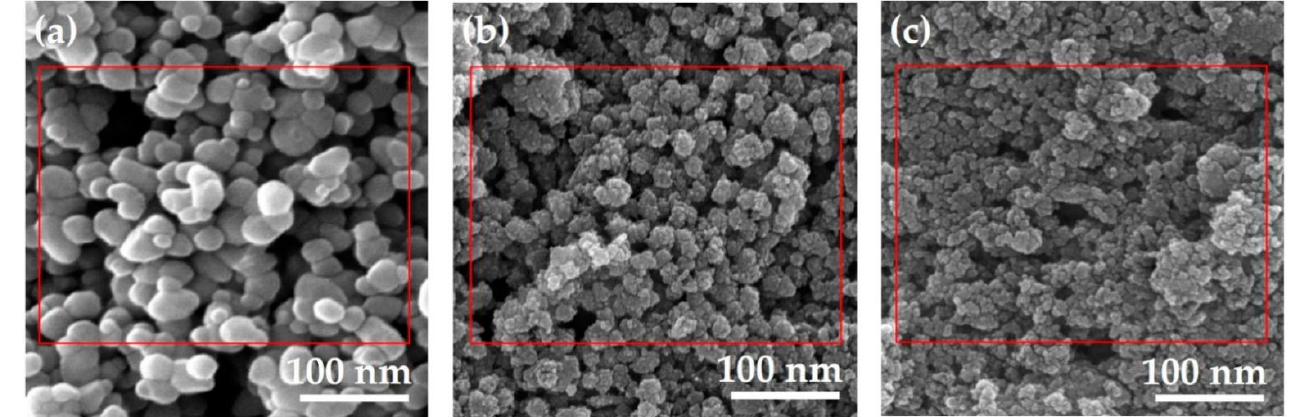
Figure 6. SEM images of different sizes of TiO 2 NPs attained from ( a ) Bacillus subtilis [79], ( b ) Cassia fistula , and ( c ) hydrothermal heating [80].